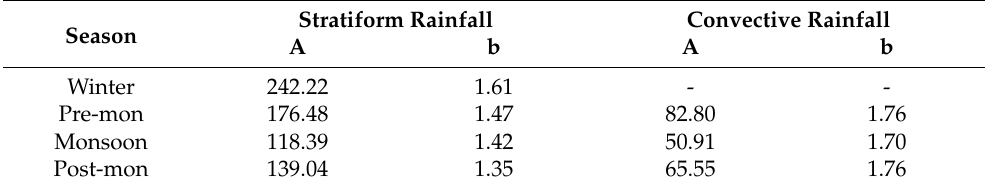
Figure 12. Scatterplots of radar reflectivity factor ( Z ) and rain rate ( R ) and fitted Z – R relationships using the least squares method (solid lines) for stratiform rain ( a ) and convective rain ( b ). Table 6. Fitted radar reflectivity and rain rate ( Z–R ) relationships for stratiform and convective rain types in the four seasons.